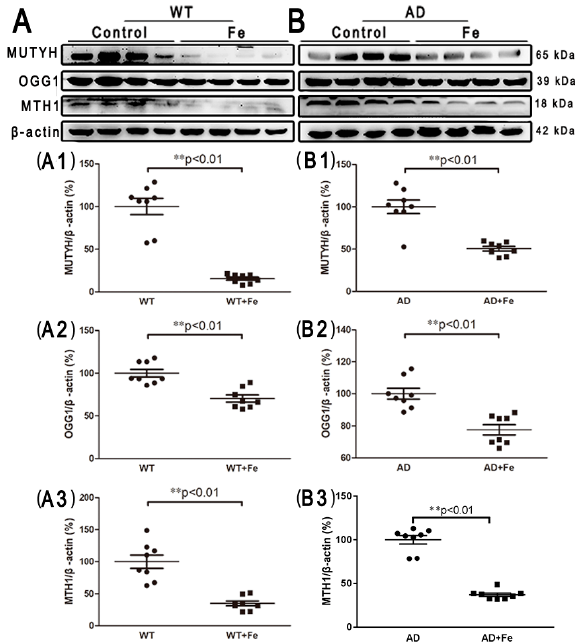
Figure 5. HDI-induced oxidative DNA damage in the mouse brain. ( A , B ) Western blot analysis of MutY homologous DNA glycosidase (MUTYH), 8-hydroxyguanine DNA glycosidase (OGG1), and 8-hydroxy guanine nucleotidase (MTH1). ( A1 – A3 , B1 – B3 ) Quantitative analyses of Western blot for MUTYH, OGG1, and MTH1. β -actin was used as an internal control. All results are presented as the mean ± SEM ( n = 8). ** p < 0.01.